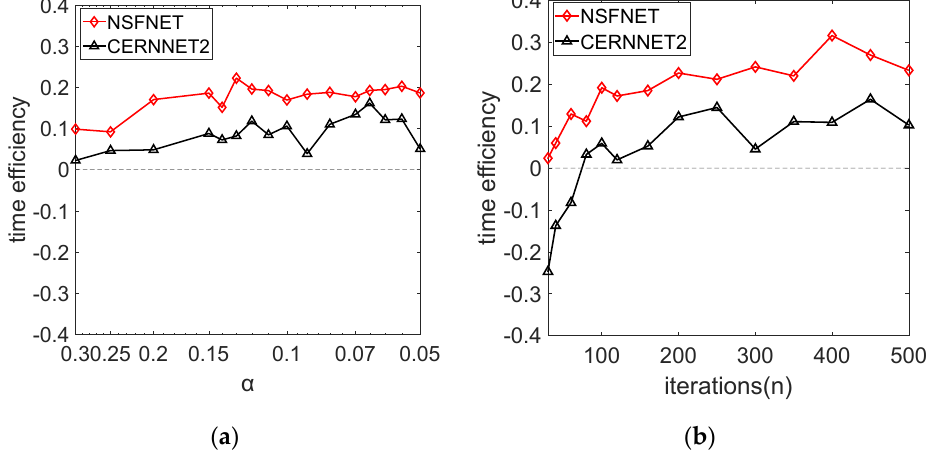
Figure 6. Time efficiency optimization of heuristic SFC deployment algorithm based on NBACO-SS: ( a ) NB-ABSA; ( b ) NB-ETS.